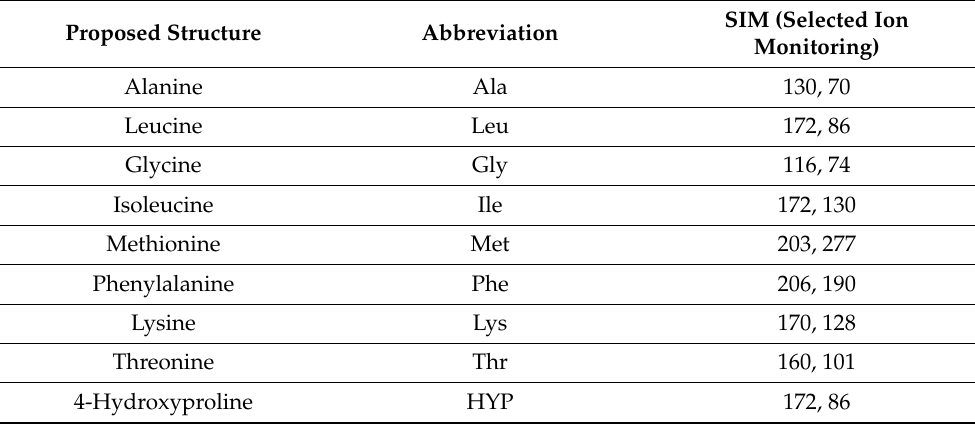
Table 1. Main compounds identified by GC-MS analysis of plant extract.